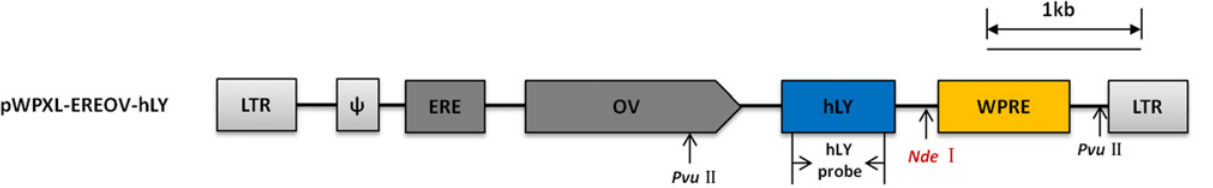
Fig 2. A schematic representation of the structure of the lentiviral vector used to generate G 0 chimeric chickens. LTR, long terminal repeat; ψ , packaging signal; ERE, oestrogen responsive element; OV, chicken ovalbumin promoter; hLY, chicken egg white lysozyme signal peptide and the cDNA sequence of human lysozyme; WPRE, woodchuck hepatitis virus post-transcriptional regulatory element; The positions of Pvu II and Nde I restriction sites and the hybridisation probe used in Southern blot analysis are